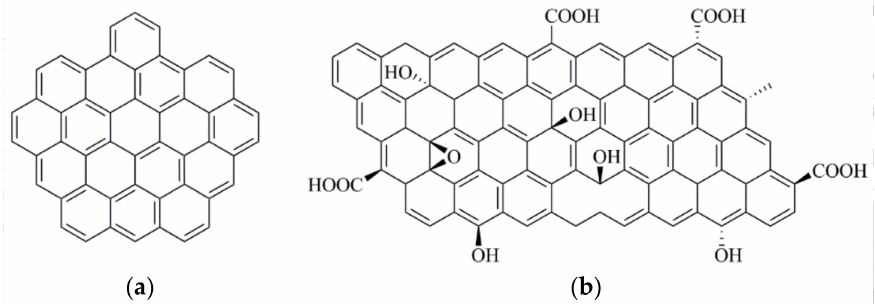
Figure 2. Scheme of a single layer of ( a ) graphene or ( b ) graphene oxide.